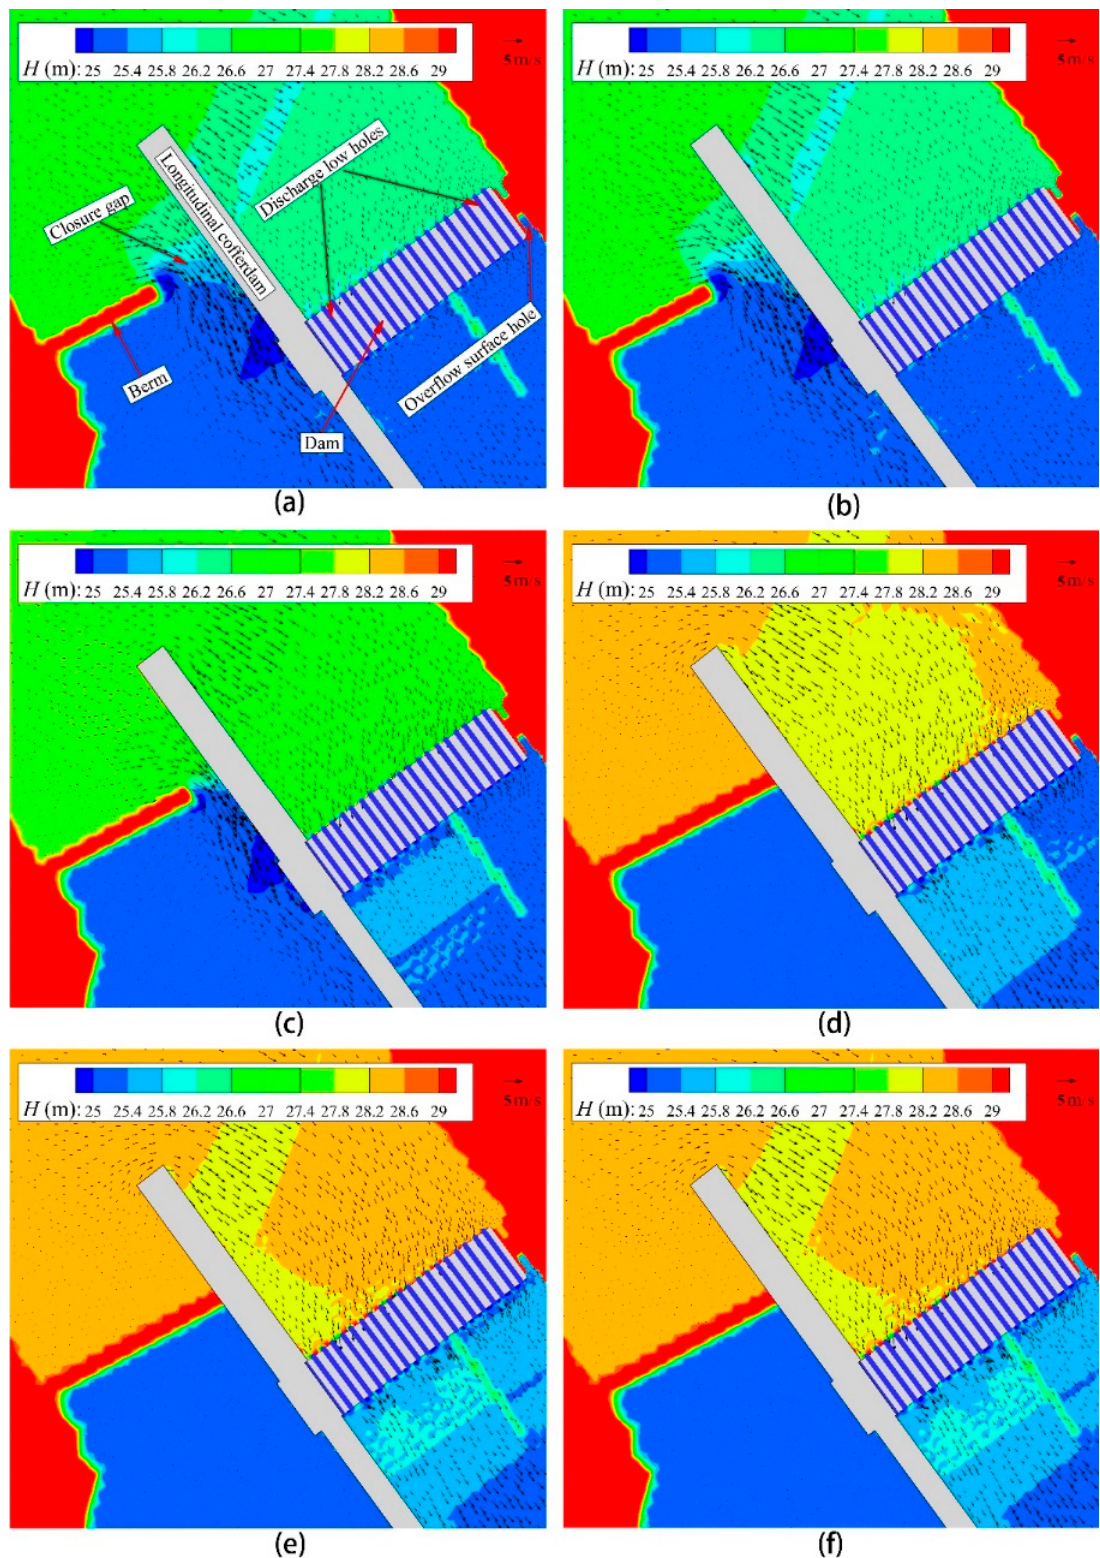
Figure 17. The flow field at different times: ( a ) t = 15 h; ( b ) t = 20 h; ( c ) t = 25 h; ( d ) t = 30 h; ( e ) t = 35 h; ( f ) t = 50 h. The color represents water level or terrain elevation at nodes. The vector is velocity.